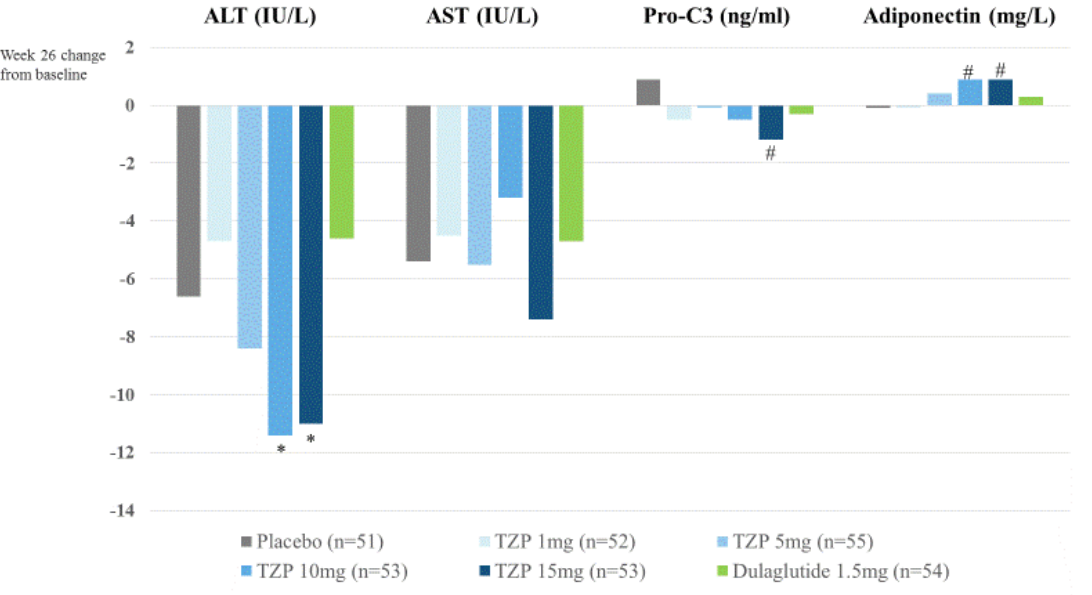
Figure 2. Sub-analyses of efficacy and safety of tirzepatide (TZP) in patients with type 2 diabetes: a randomized, placebo-controlled, and dulaglutide-controlled phase 2 trial [57]. * p < 0.05 change from baseline vs. Dulaglutide. # p < 0.05 change from baseline vs. placebo.